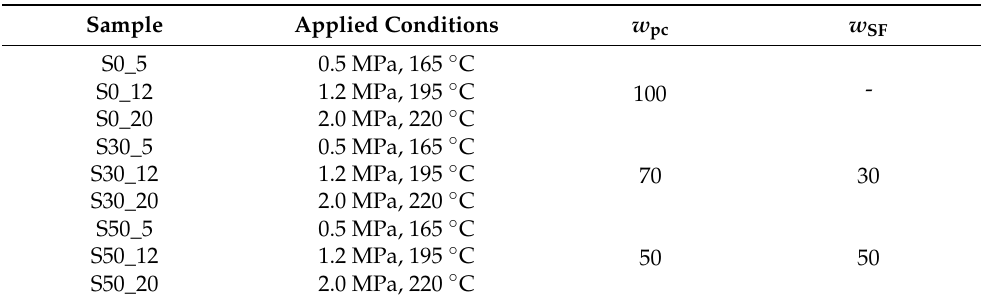
Table 1. Composition of prepared samples (in mass%) and their designation according to the applied hydrothermal conditions.